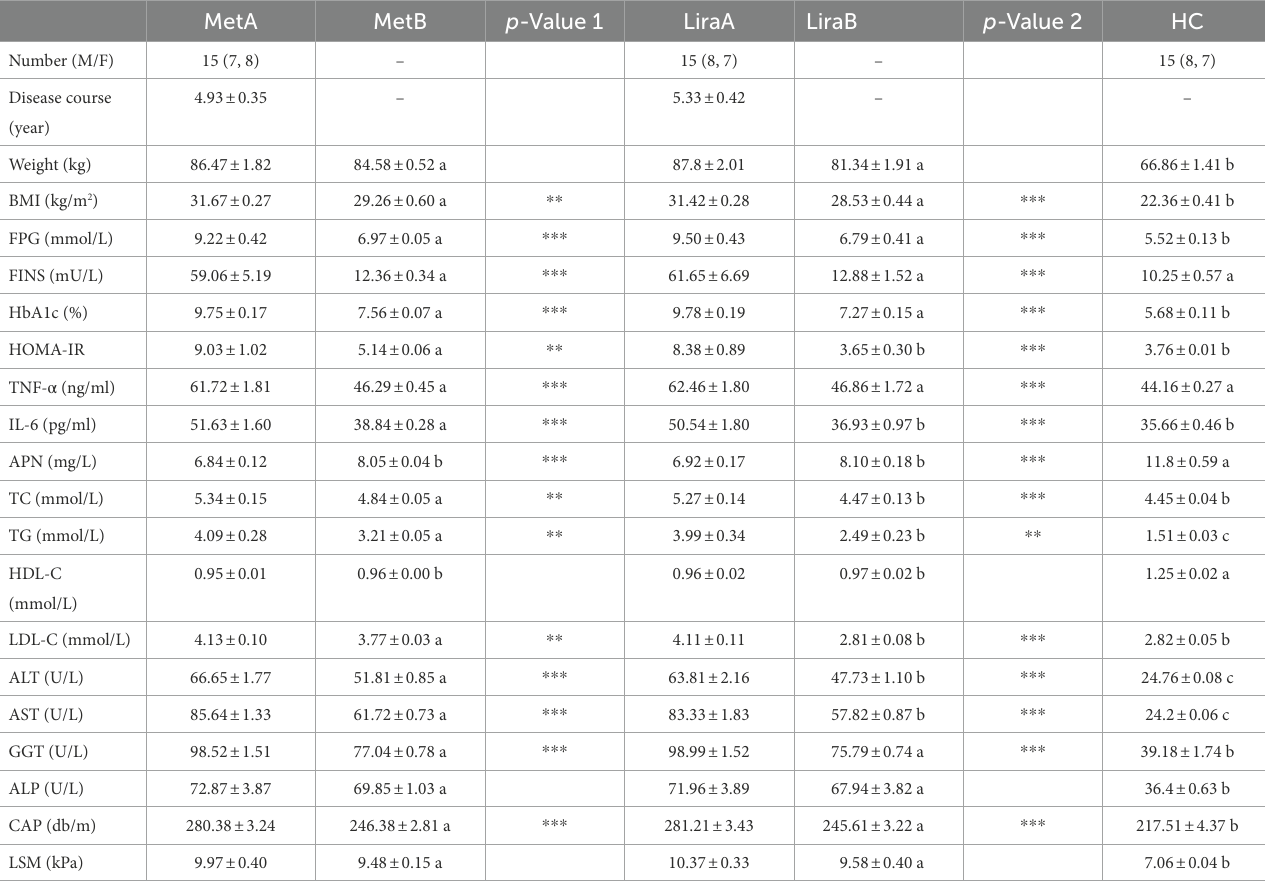
TABLE 1 Changes of clinical indices before and after msetformin or liraglutide treatment and comparison with healthy controls.